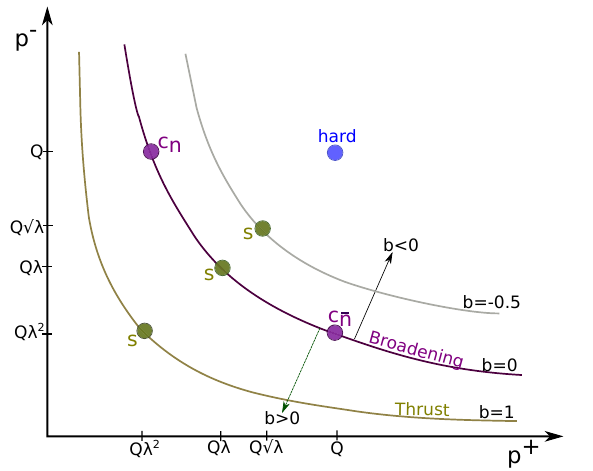
Figure 1 . Invariant mass-hyperbolae and momentum scaling of collinear ( c degrees of freedom for angularities with different exponents b . The power counting parameter λ is defined as λ 1+ b τ b ∼